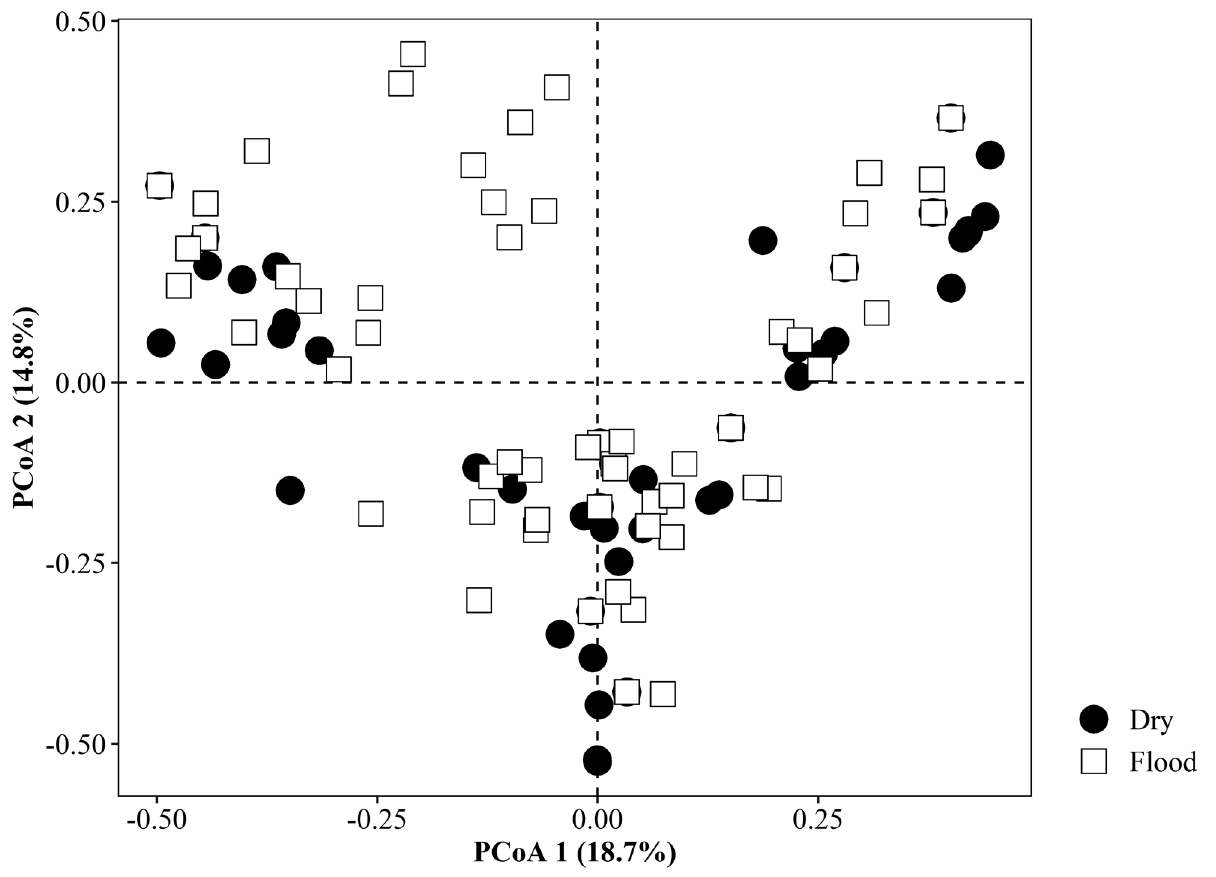
FIGURE 3 | Ordination of the diet of Hyphessobrycon heterorhabdus between hydrological periods in eight streams of a protected area in the Eastern Amazon, Brazil.